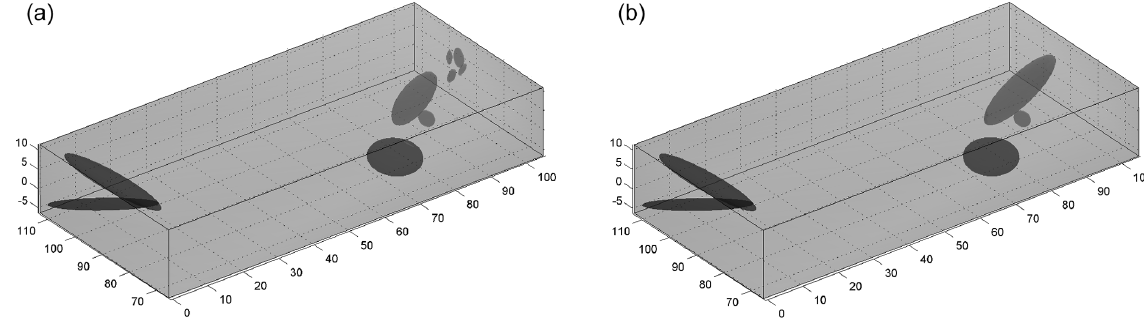
Figure 4. The final models obtained using the local (a) and global (b) merging criteria for the dataset presented in Fig. 2. The number of clusters, including the uniform background kernel, is 11 and 6 for the local and global criteria